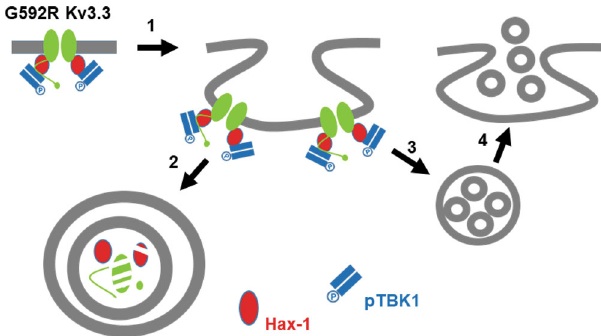
Fig. 10 Diagram of potential interactions in G592R Kv3.3-induced TBK1 signaling. The fi gure shows endocytosis of the receptor complex (1) and traf fi cking into multivesicular bodies (2 and 3) that can fuse with lysosomes (2) or promote the release of multivesicular bodies in the